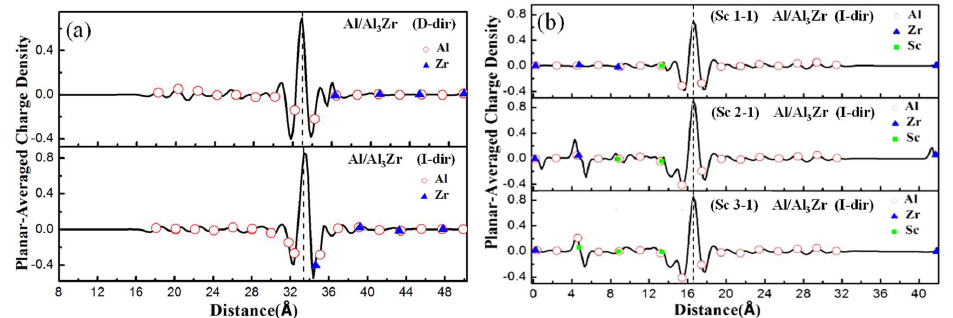
Figure 7. Planar-averaged differential electron density. ( a ) Al/Al 3 Zr interfaces with D-ter and I-ter, ( b ) Al/Al 3 (Zr, Sc) interfaces with different Sc-doping ratio. Valence charge density is averaged on each (001) plane. The supercell containing 12 layers of Al 3 (Zr, Sc) and eight layers of Al with a vacuum region is shown. Red circle, blue triangle, and solid green circle indicate the positions of Al, Zr, and Sc in atomic layers, respectively. The interface is marked by a vertical line.